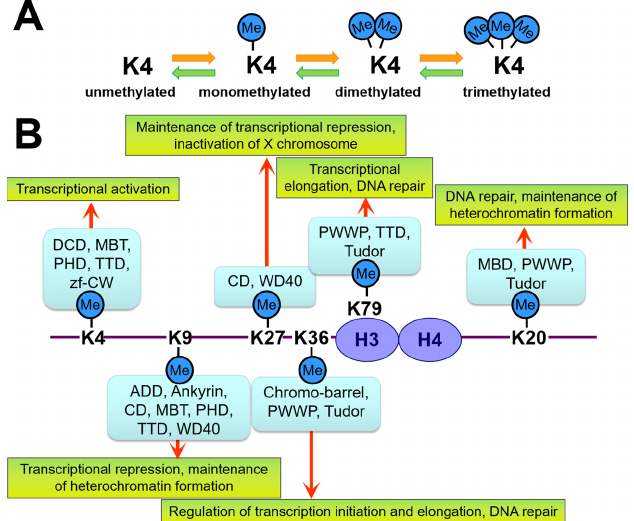
Figure 1. Schematic showing how lysine (K) methylation (Me) is recognized by different domains of “reader” proteins and their outcomes. ( A ) Each lysine residue on the histone can either be mono-, di-, or trimethylated. Each of these post-translational modifications is recognized by different “reader” proteins. ( B ) Methylation of lysine residues of H3 and H4 and the protein domains that recognize them. The binding proteins, and not histone modification, change the chromatin struc- ture. ADD—Alpha-thalassemia intellectual disability syndrome X-linked (ATRX)-DNMT3- DNMT3L; CD—chromodomain; MBD—methyl-lysine-binding domain; MBT—malignant brain tu- mor; PHD—plant homeodomain; PWWP—conserved Pro-Trp-Trp-Pro motif; TTD—tandem Tudor domain; zf-CW—zinc-finger CW.